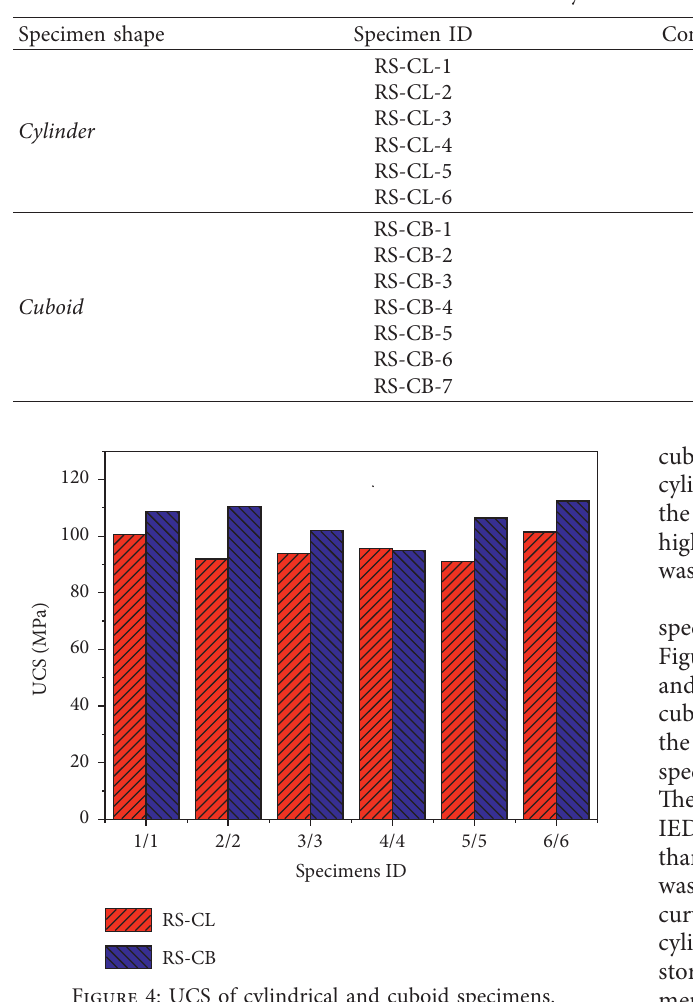
Figure 4: UCS of cylindrical and cuboid